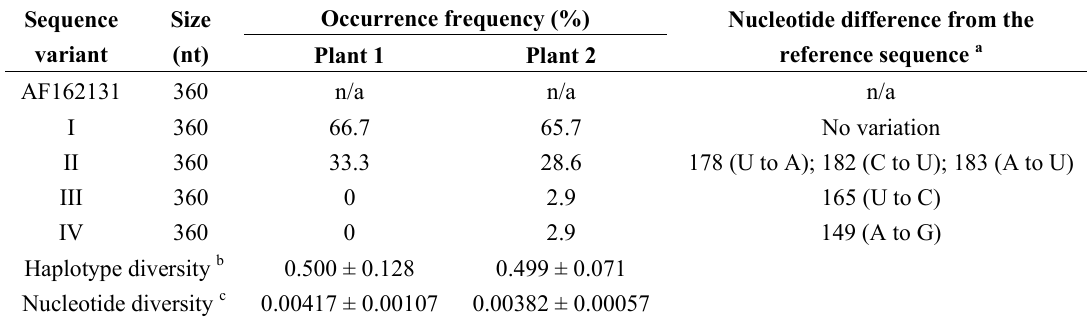
Table 1. Tomato chlorotic dwarf viroid (TCDVd) sequence variant population structure, occurrence frequency and nucleotide variation in TCDVd isolate Trust-infected tomato plants. Occurrence frequency (%) Nucleotide difference from the Sequence Size variant (nt)